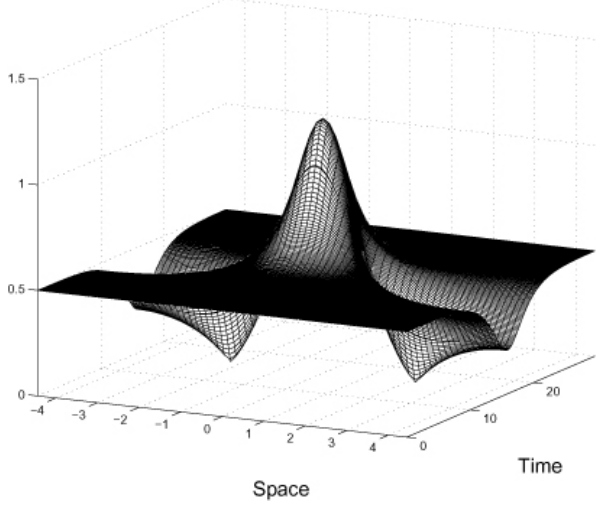
Fig. 2. Amplitude plot of a homoclinic orbit of the Stokes wave √ with a = 0 . 5, L = 2 2 π